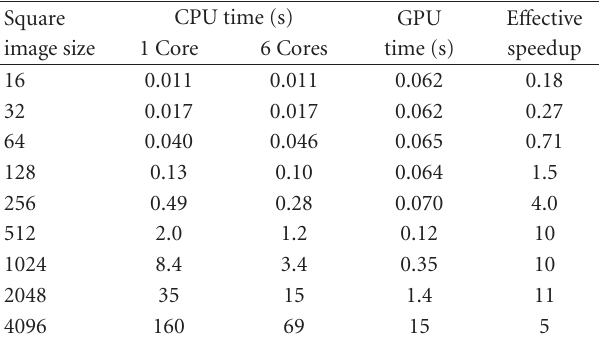
Table 3: Double-precision GPU CS MRI reconstruction times for test images ranging from 16 2 to 4096 2 with and without CPU mul- tithreading. E ff ective speedup is the multicore CPU time relative to the GPU time.